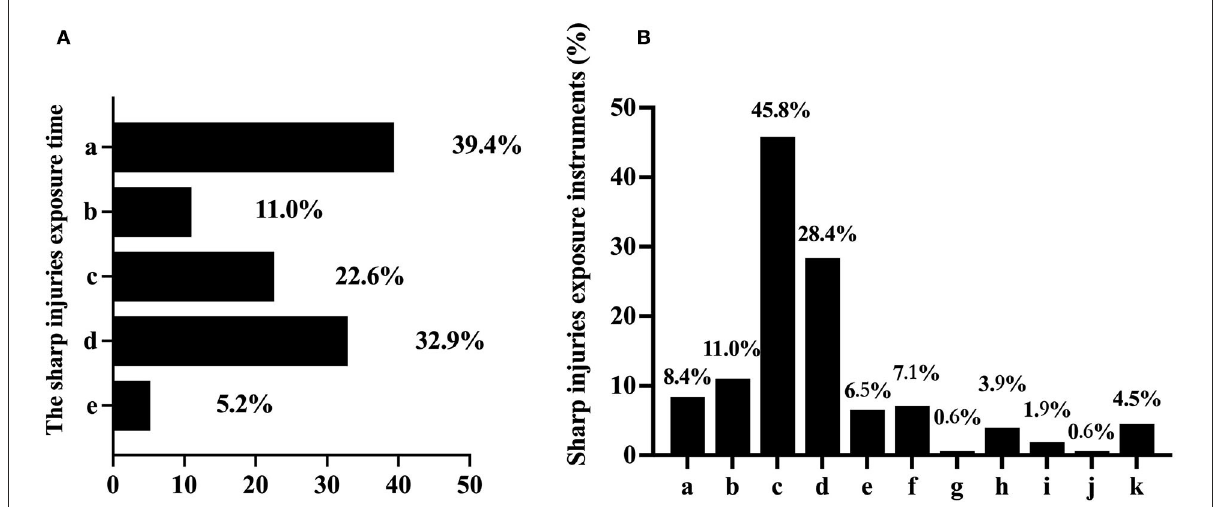
FIGURE1 The basic situation of sharp injury exposures (%). (A) The exposure time of sharp injuries; a. preparing sharp objects; b. transferring sharp objects; c. operation; d. discarding waste; e. unclear. (B) Instruments which may induce sharp injuries: a. scalpel; b. suture needle; c. syringe needle; d. endodontic file; e. ultrasonic tip; f. drilling needle; g. gracey curette; h. periodontal probe; i. barbed broach; j. irrigation needle; k. ligature